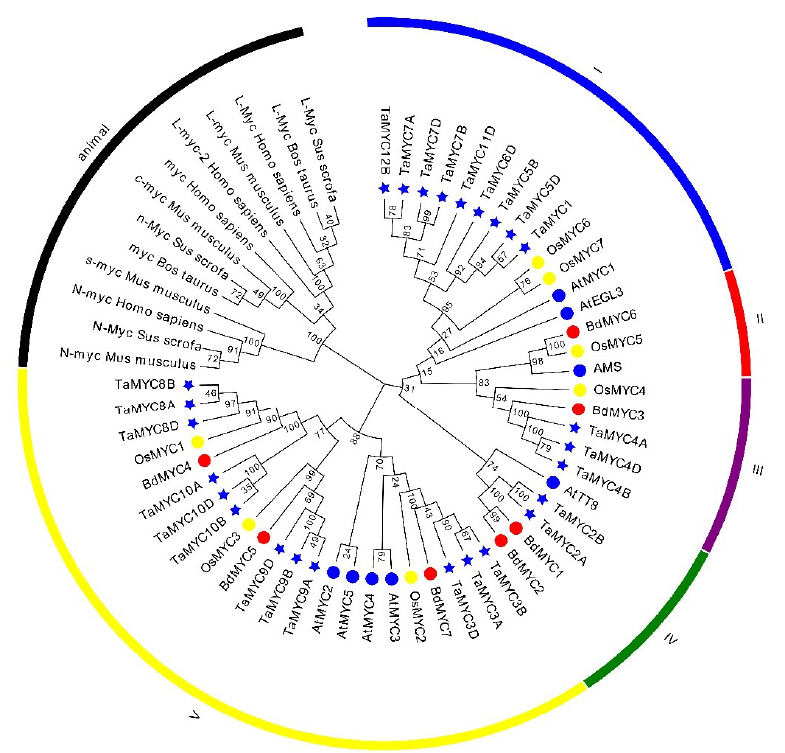
Figure 3. Phylogenetic tree of 61 MYC transcription factors (TFs). There are 48 plant MYCs and 13 known animal MYCs. The Ta, Os, Bd, and At represent wheat, rice, B. distachyon, and Arabidopsis, respectively.